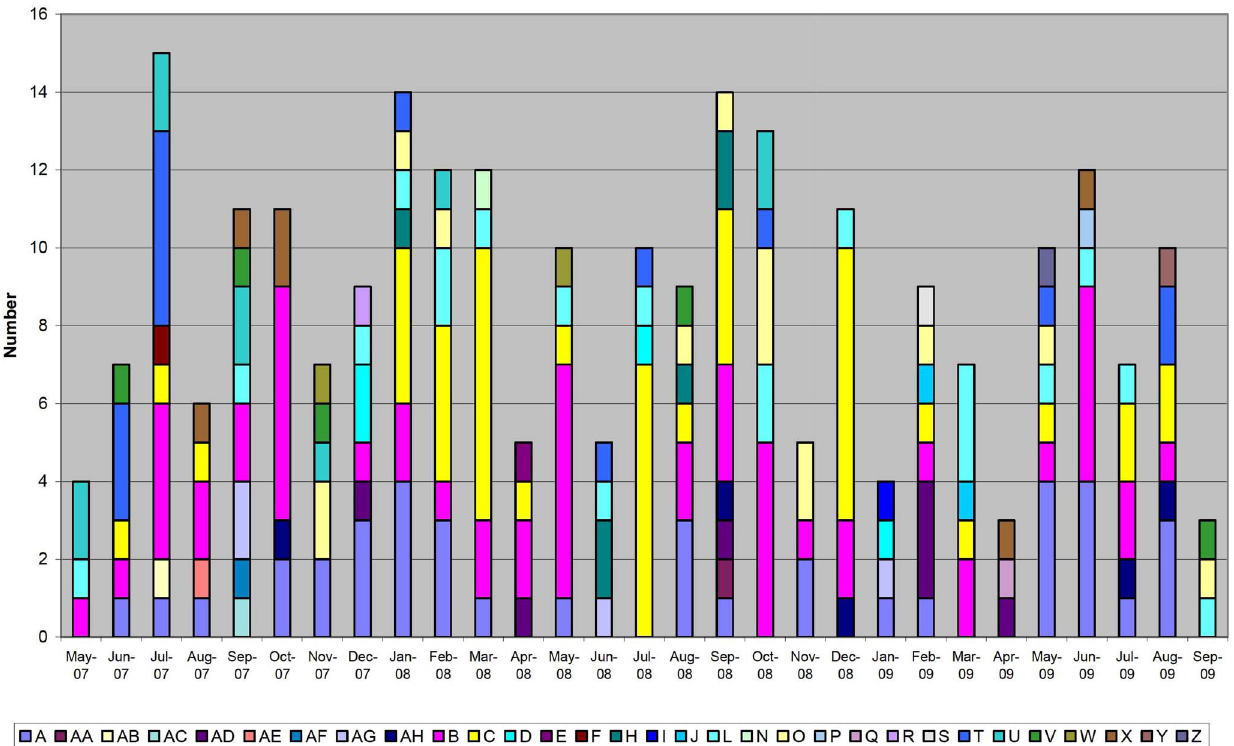
Figure 1. PFGE subtypes. doi:10.1371/journal.pone.0058112.g001 1.8 supports extra-Poisson variation. We used a model of segmented regression, allowing for a step change at the time of the intervention, and estimated parameters based on an assumed